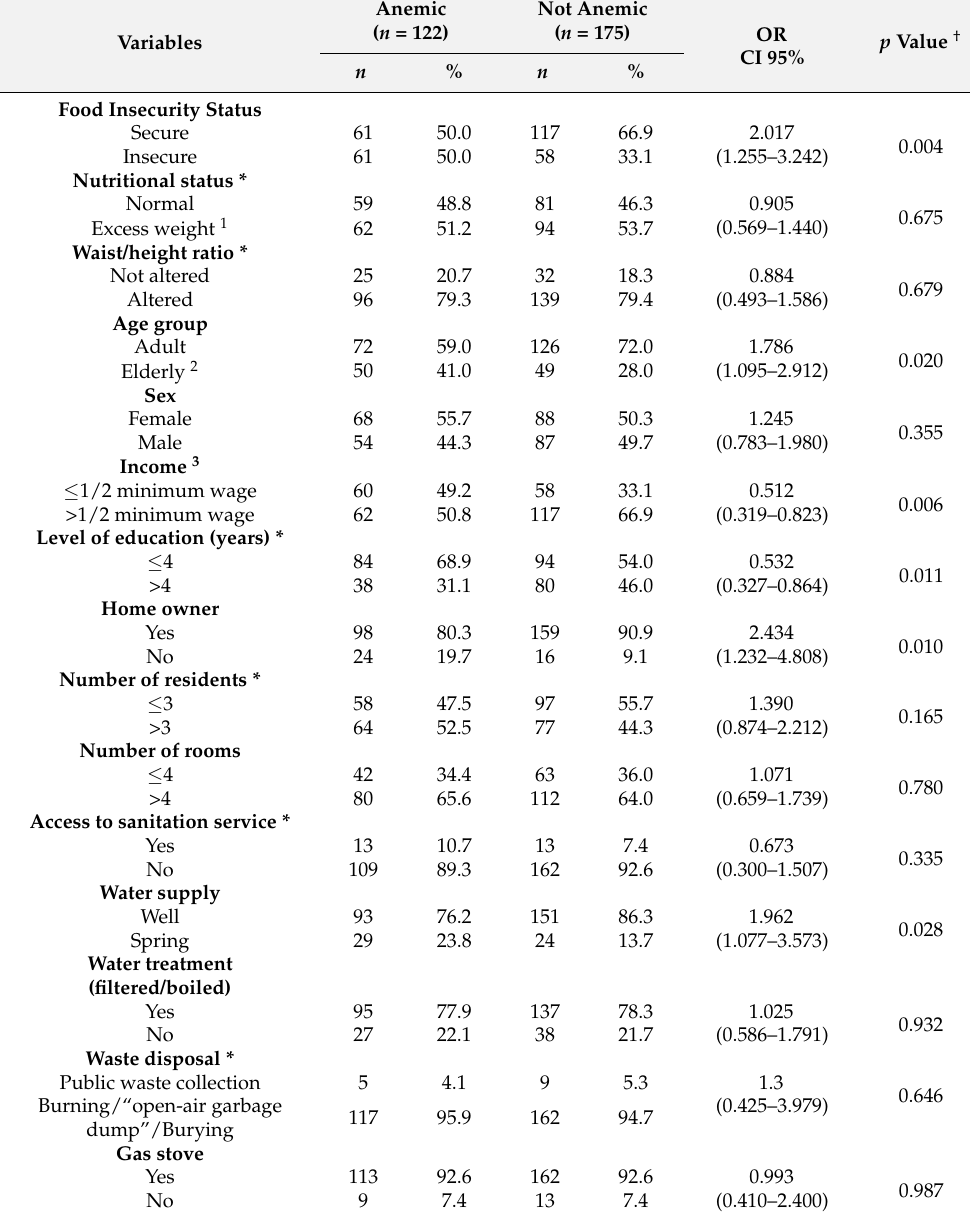
Table 2. Prevalence of anemia in rural households in a municipality of Brazil, according to the assessment of food security, nutritional status, socioeconomic, demographic, and housing